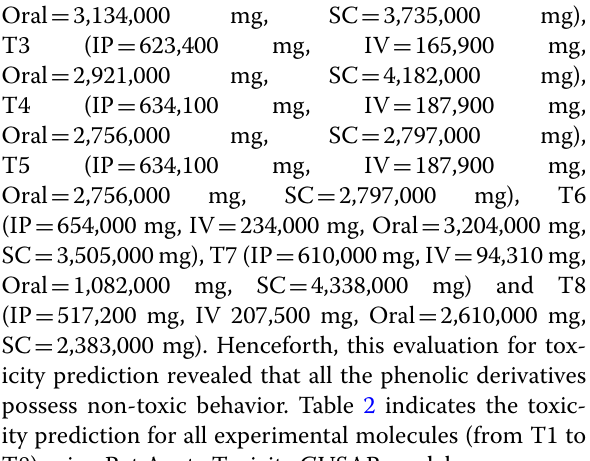
Table 2 Toxicity prediction for all experimental molecules (from T1 to T8) using Rat Acute Toxicity GUSAR model Route of administration